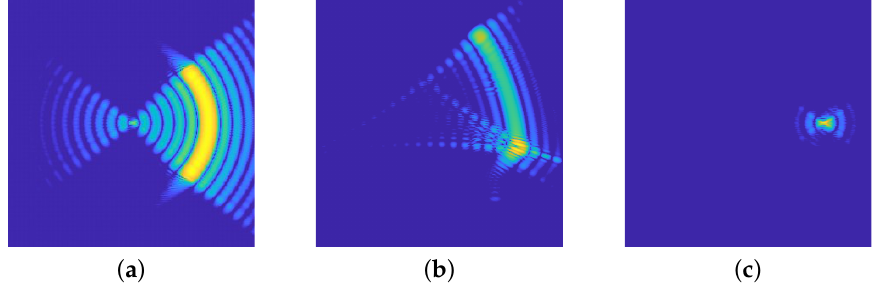
Figure 3. Schematic diagram of the motion error geometric model of the AST.